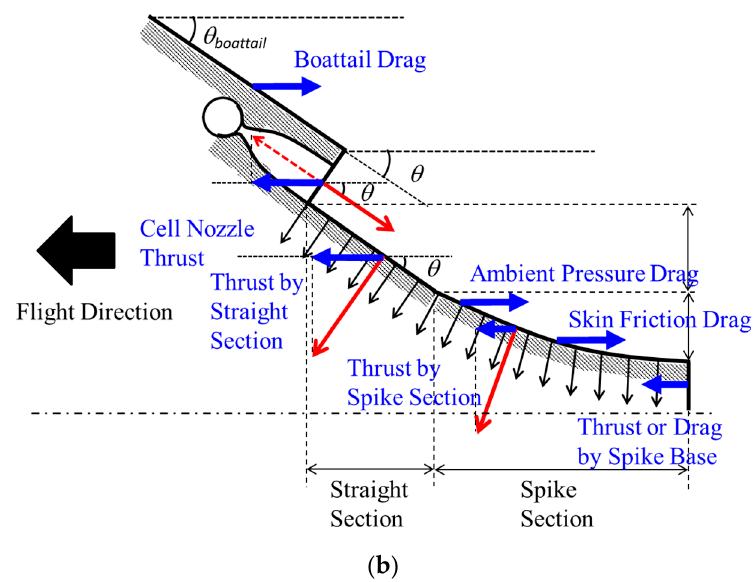
Figure 7. Illustrations of pressure distributions acting on the aftbody surface. ( a ) Cases 2 to 3; ( b ) Case 4.